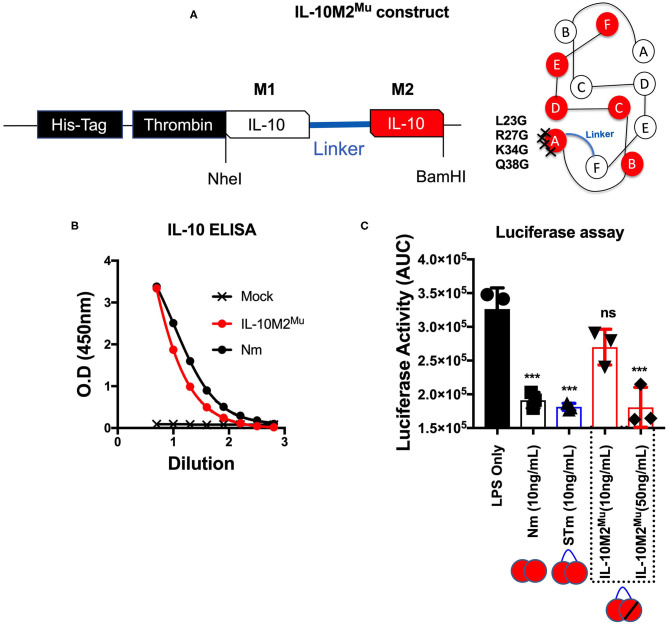
Mutations introduced into one monomer of stable mouse IL-10 at the IL-10R binding site (IL-10M2Mu). (A) The cDNA construct of both un-mutant IL-10 and IL-10M2Mu was cloned into the expression vector (pCEP V19) and the cartoon illustration of IL-10M2Mu with the location of the 4-points mutations at the IL-10 receptor-binding site on the helix A of IL-10 protein. (B) Purified IL-10M2Mu detected by ELISA (1/2 dilutions) to evaluate the expression level. (C) Assessment of luciferase suppression after LPS (10 ng/mL) treatment and either co-treated with Nm (10 ng/mL), STm (10 ng/mL), or IL-10M2Mu at (10 and 50 ng/mL). The significant difference is calculated concerning LPS stimulated cells only and symbolized as ***p < 0.001, ns (non-significant). All data are representative of three independent experiments, with triplicate cultures per experiment (N = 3, n = 3), and bars represent standard error of the mean.